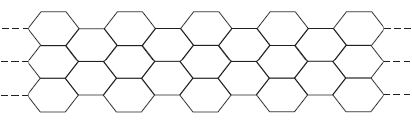
Figure 2. The 3D lattice of the zigzag TUZC 6 [ 10,7 ]